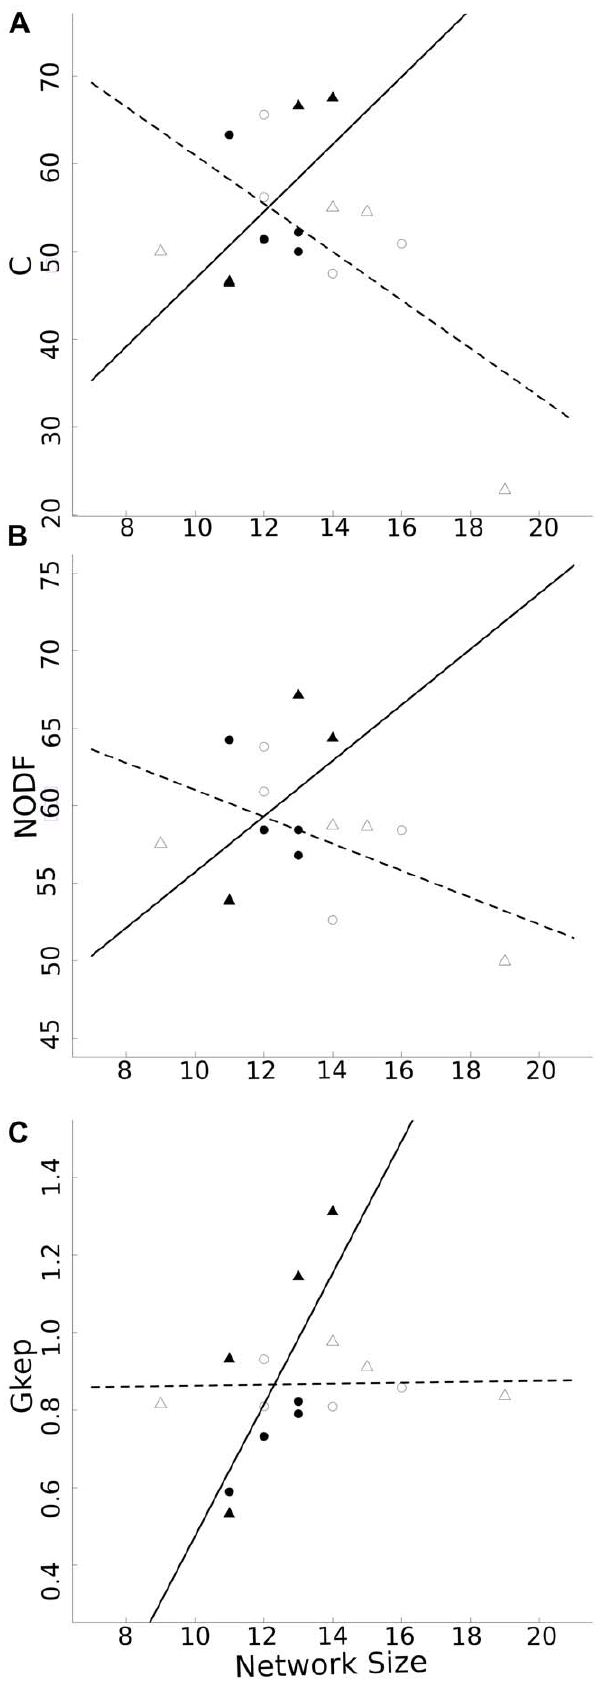
Figure 2. Effect of network size on several descriptors of comensalistic network topology. a) Connectance, C. b) Almeida- Neto’s nestedness, NODF.[40] C) Epiphyte specialization/generalization N index, G kepi . Filled symbols and solid lines indicate old-growth forest ( m Senda Darwin). Empty symbols and dashed lines indicate Caulin, disturbed forests ( # Quilar, D